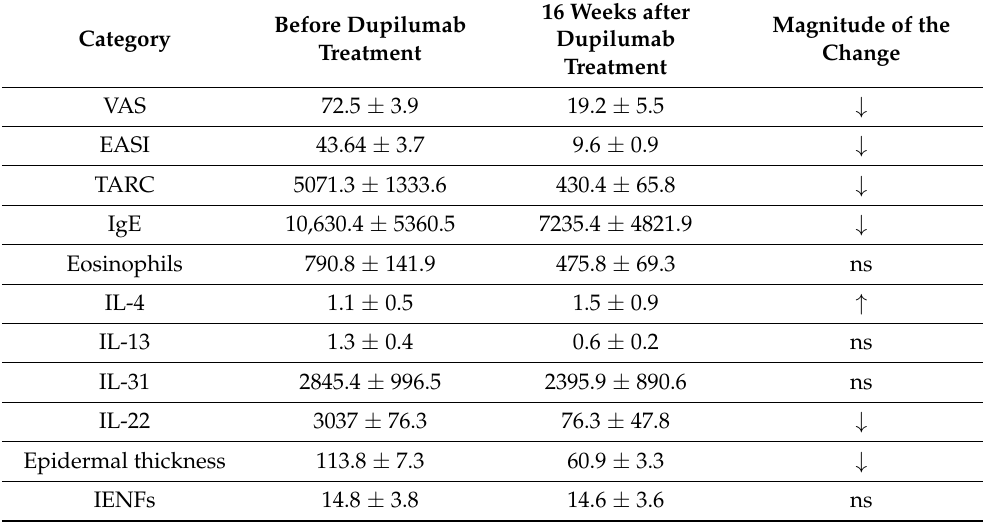
Table 2. A summary of therapeutic effects 16 weeks after the dupilumab treatment. Before Dupilumab Category Treatment